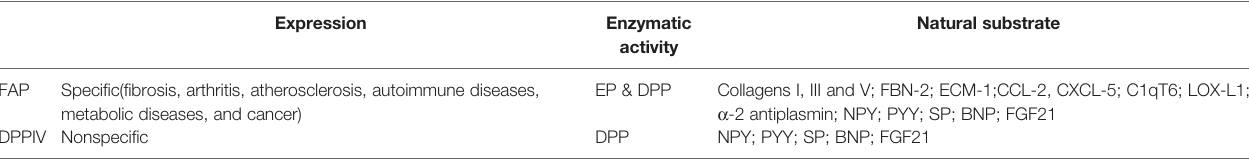
TABLE 1 | Differences between FAP and DPPIV on expression, enzyme activity, and natural